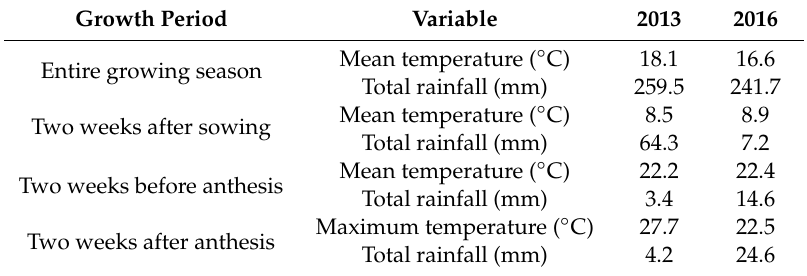
Table 1. Basic weather conditions during the entire growing season and selected growth periods in each year of the